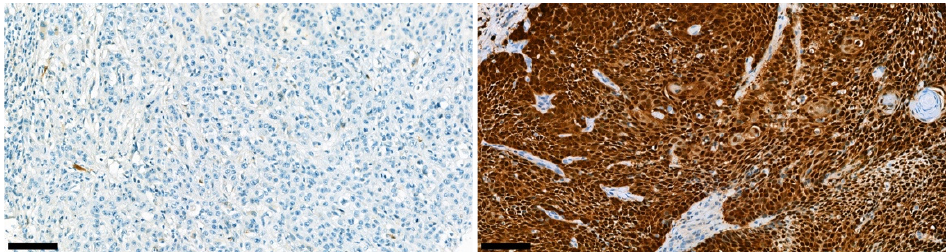
Figure 6. Representative immunohistochemical figures of negative ( left panel ) and positive ( right panel ) p16 staining. Black bars represent 100 µm.